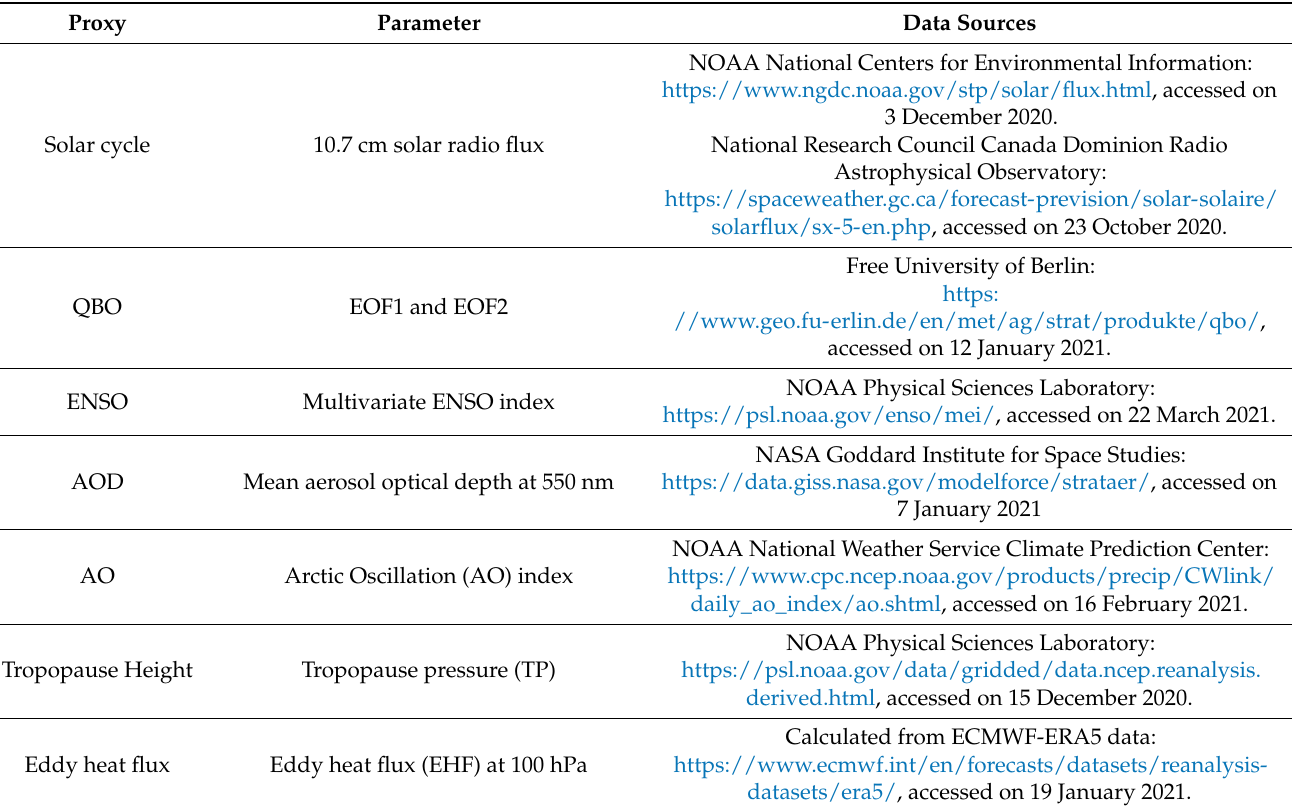
Table 1. Proxies and data sources used for the multi-linear regression